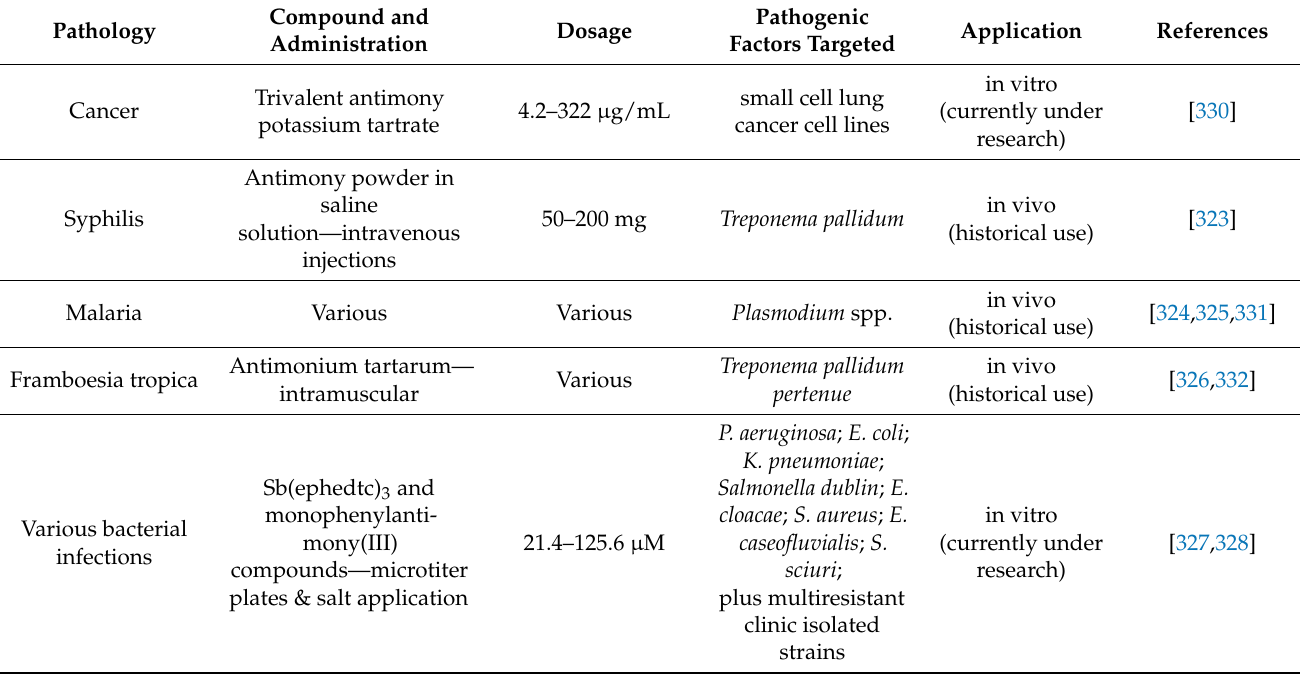
Table 4. Summary of medical uses for antimony